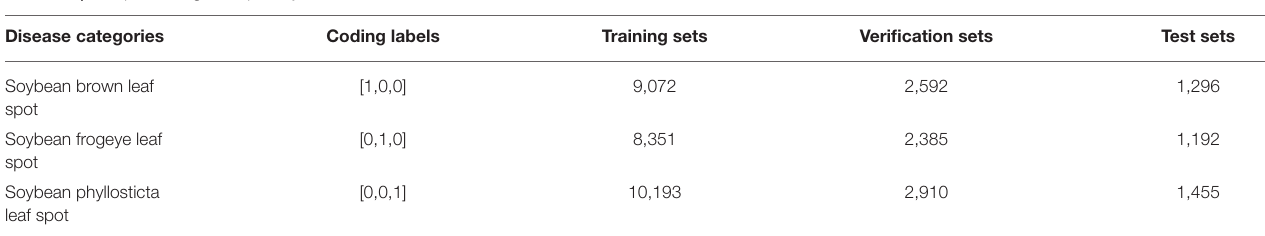
TABLE 2 | Sample coding and quantity division of various diseases. Disease categories Training sets Verification sets Test